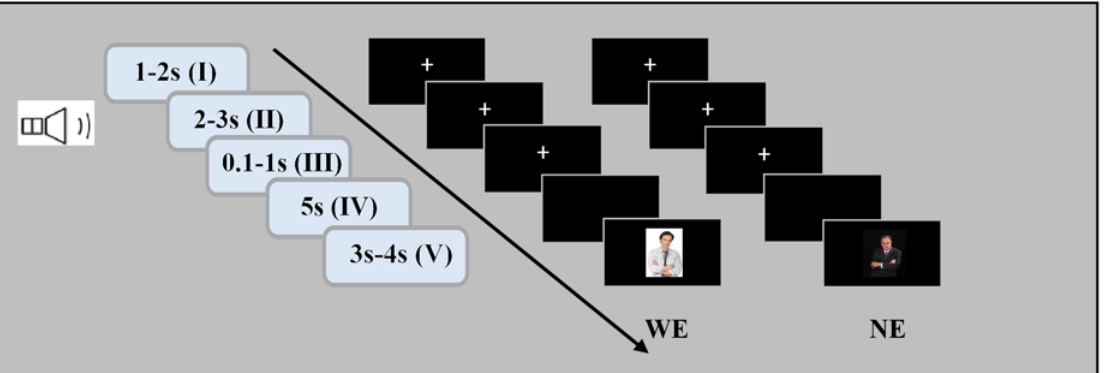
Figure 1. The WE and NE task for both the IL and IT conditions share the same schematic procedures. (I) fixation phase; (II) attending to the auditory question; (III) answering phase; (IV) mentalization phase; and (V) feedback phase, with differences in the visual images accompanying the auditory feedback for the two tasks to match the specific contexts, i.e.